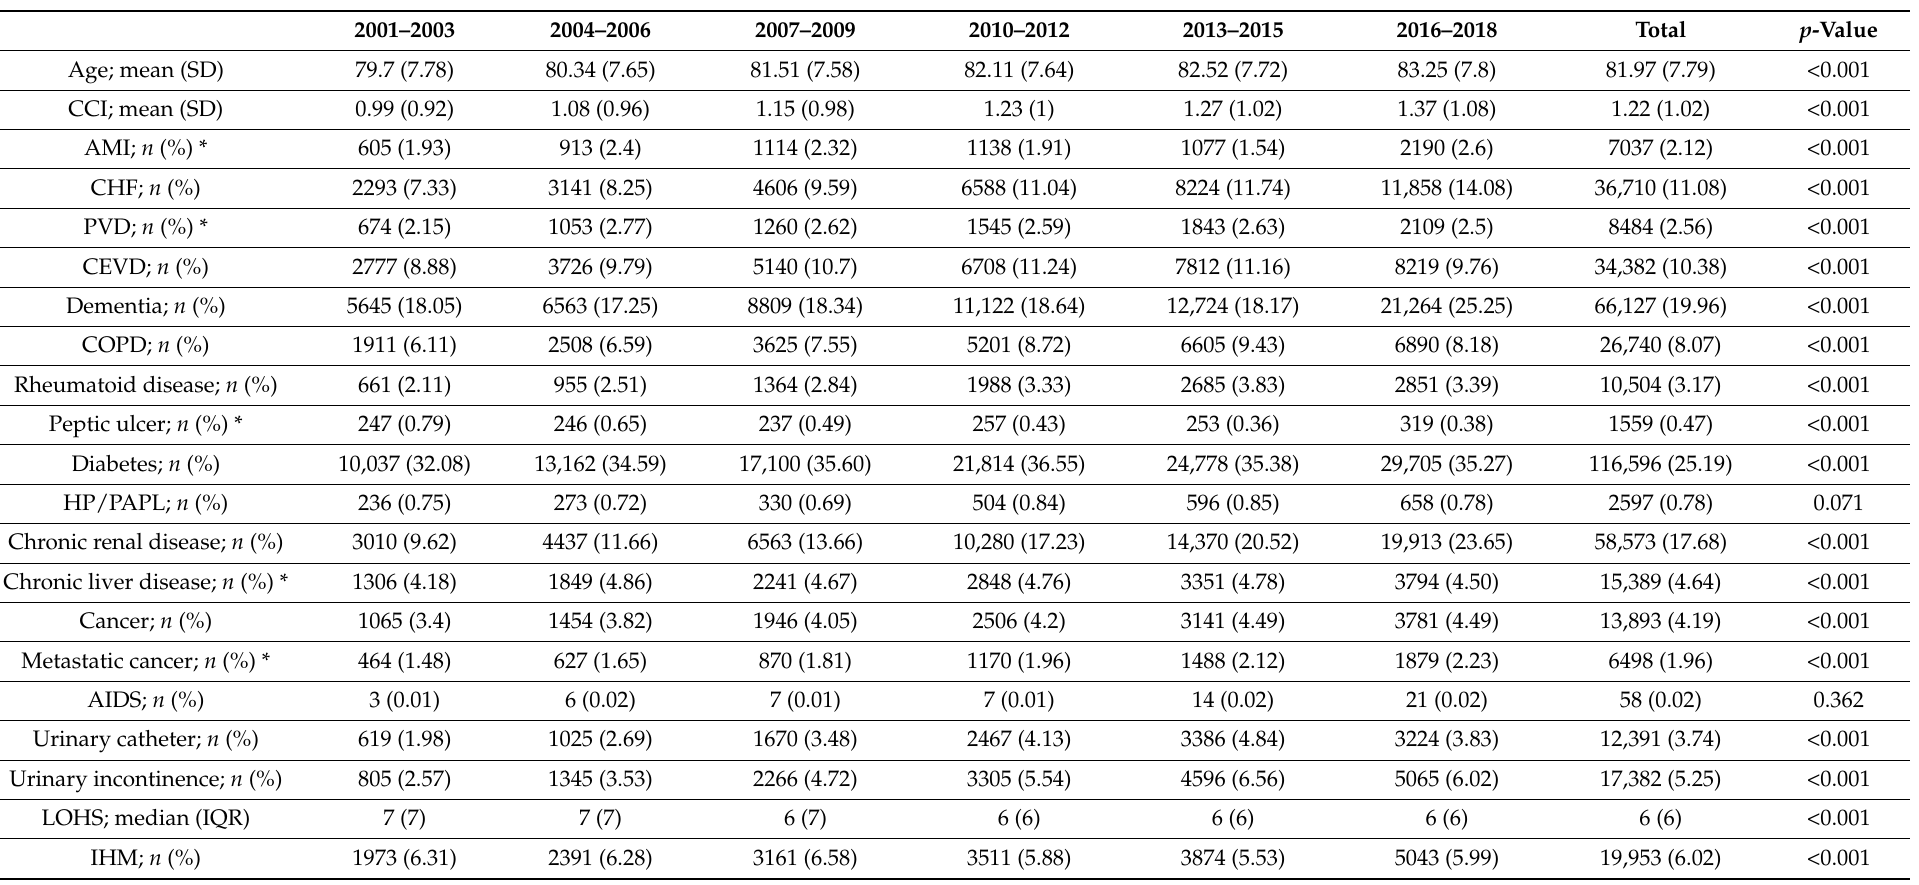
Table 3. Clinical characteristics and hospital outcomes for admissions of elderly women with a principal diagnosis of urinary tract infection in Spain